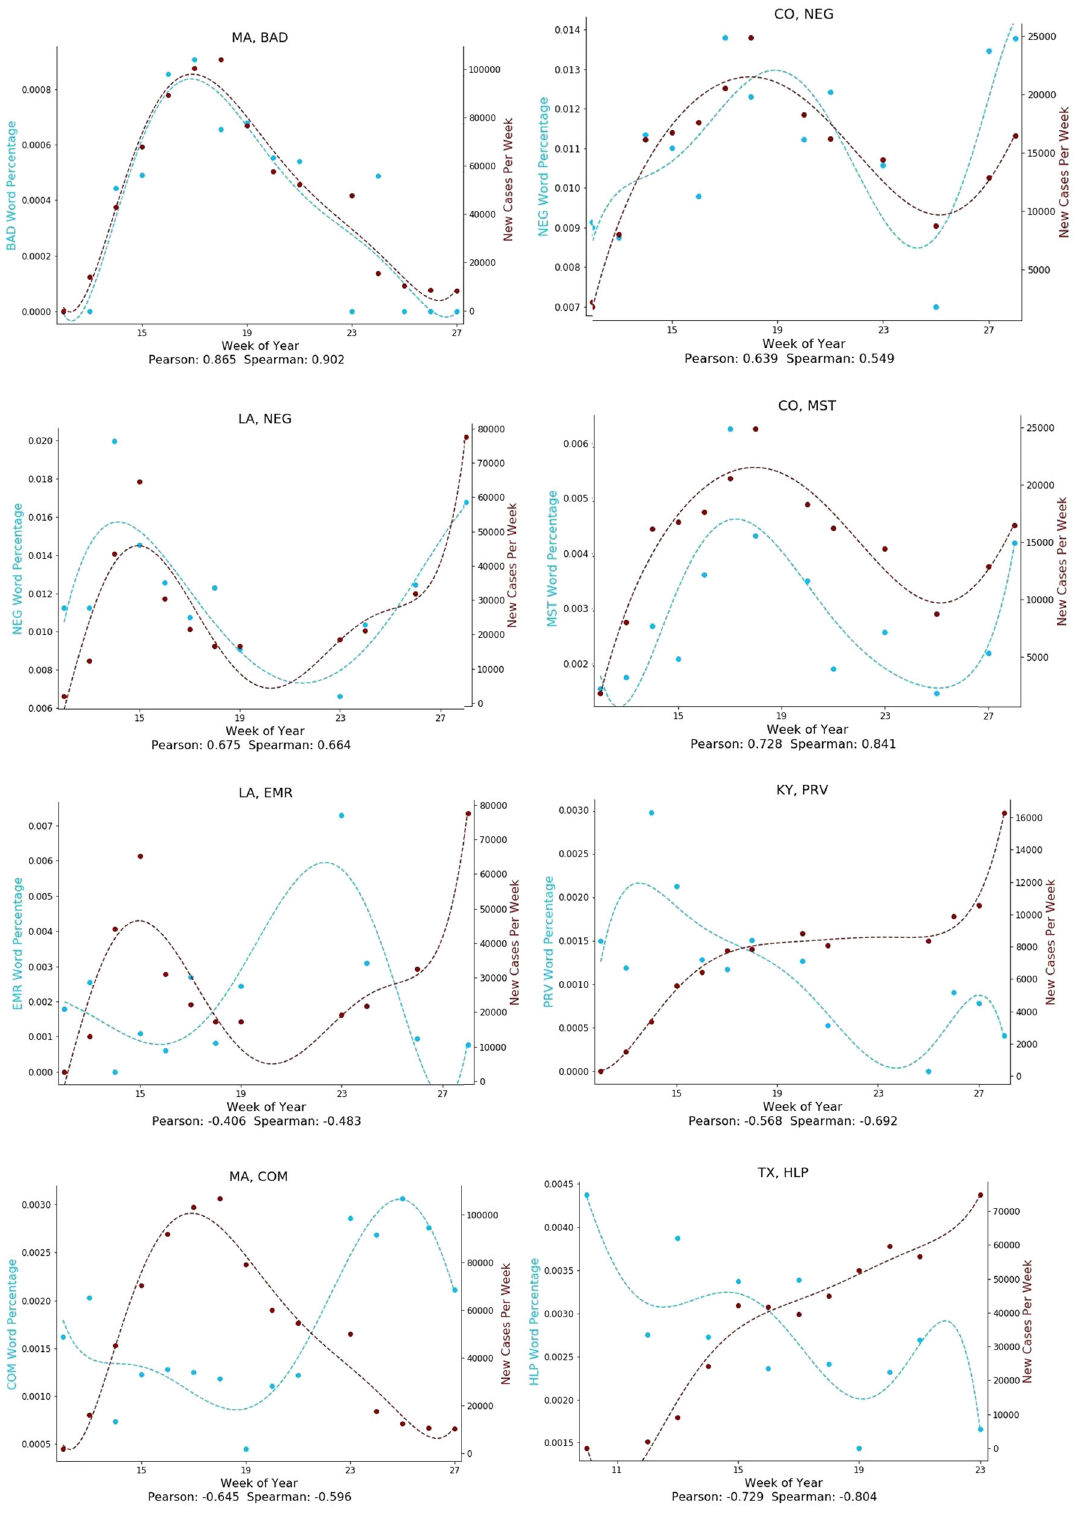
Fig. 3 Temporal associations of semantic categories with COVID-19 case rates. Both positive and negative associations are shown. States are represented by standard two-letter abbreviations. (BAD: Descriptive bad; NEG: Negation; MST: Extreme descriptive; EMR: Emergency; PRV: Preventative measures; COM: Formal communication; HLP: Help and time, as shown in Figs. 4, 7, and 8. This negative association Word length/syllable count between linguistic complexity and COVID-19 case rates was COVID-19 case rates were negatively associated with average strongest in states experiencing the highest COVID-19 case rates. word length and with average syllable count, over both space and